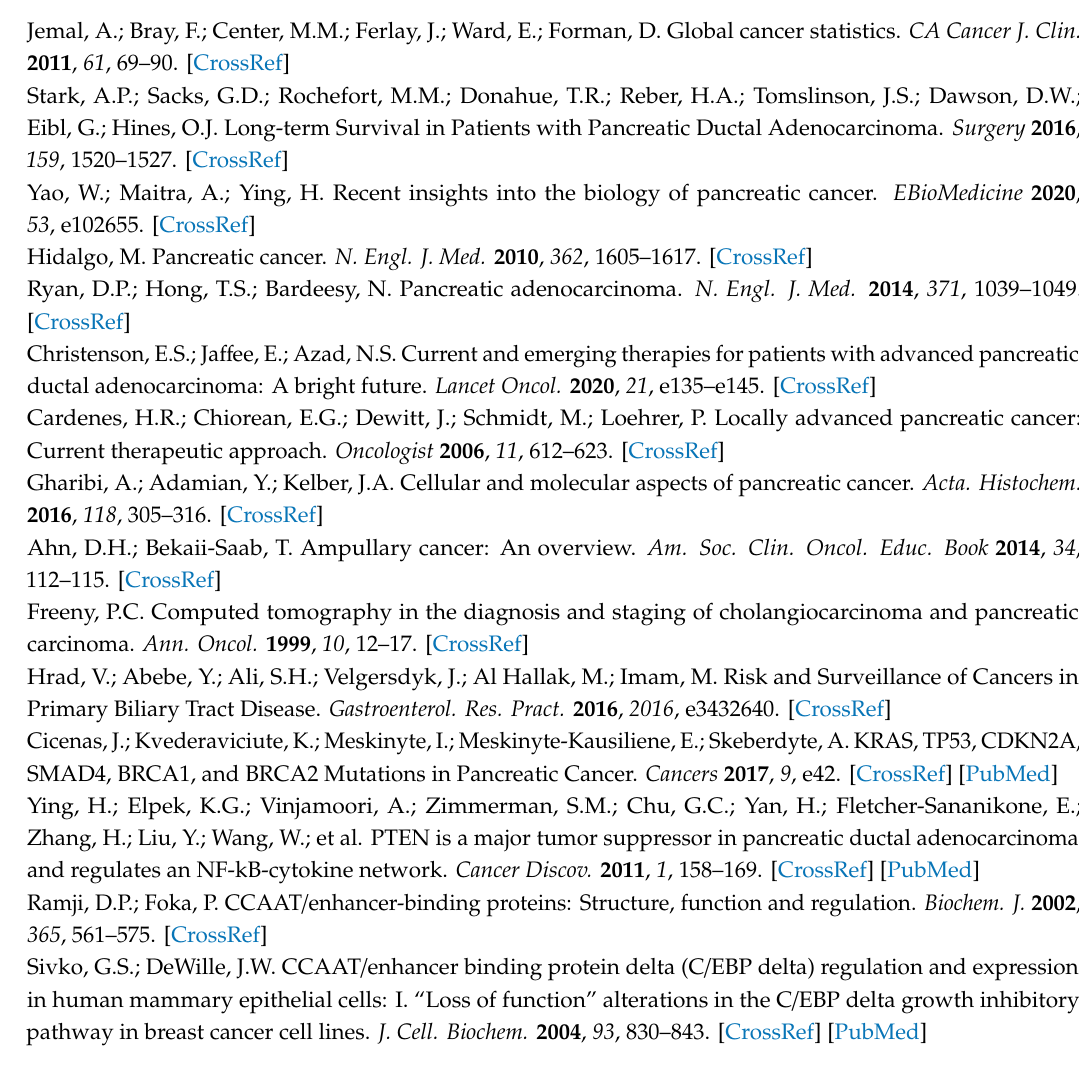
Uncropped Western blot membranes and WES ™ Simple Western images, Figure S4: mRNA expression of CEBPD across PDAC cell lines, Figure S5: mRNA expression of putative targets of CEBPD , Figure S6: Establishment of lentivirus producer cells stably expressing CEBPD